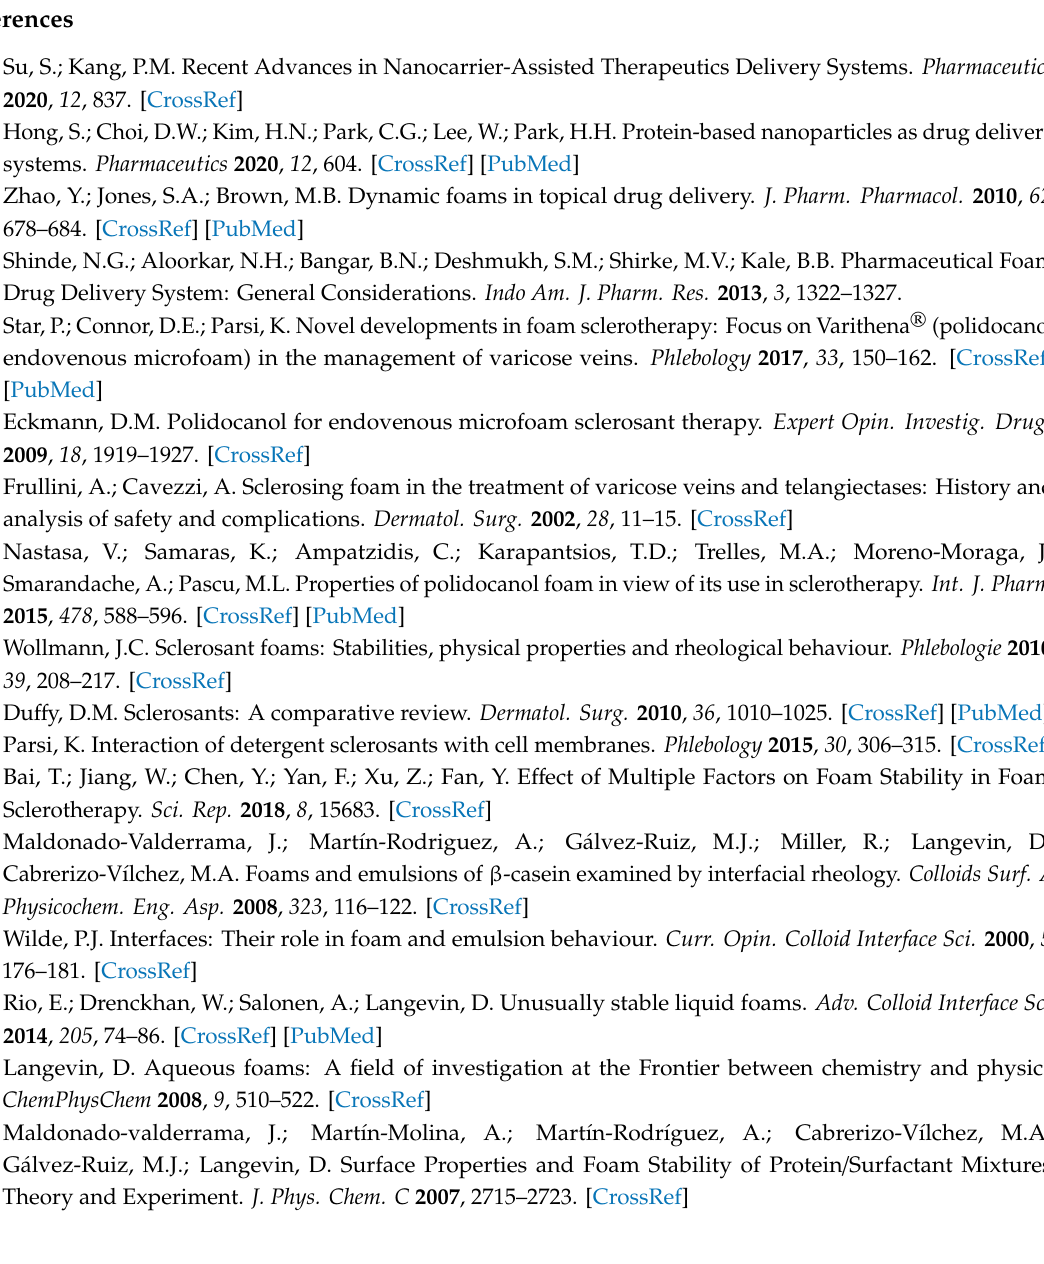
Figure S1: Foam stability of POL with additives. Figure S2: Dynamic surface tension of POL. Figure S3: Surface tension isotherms of POL with additives. Figure S4: Surface elasticity and viscosity of POL with additives at di ff erent